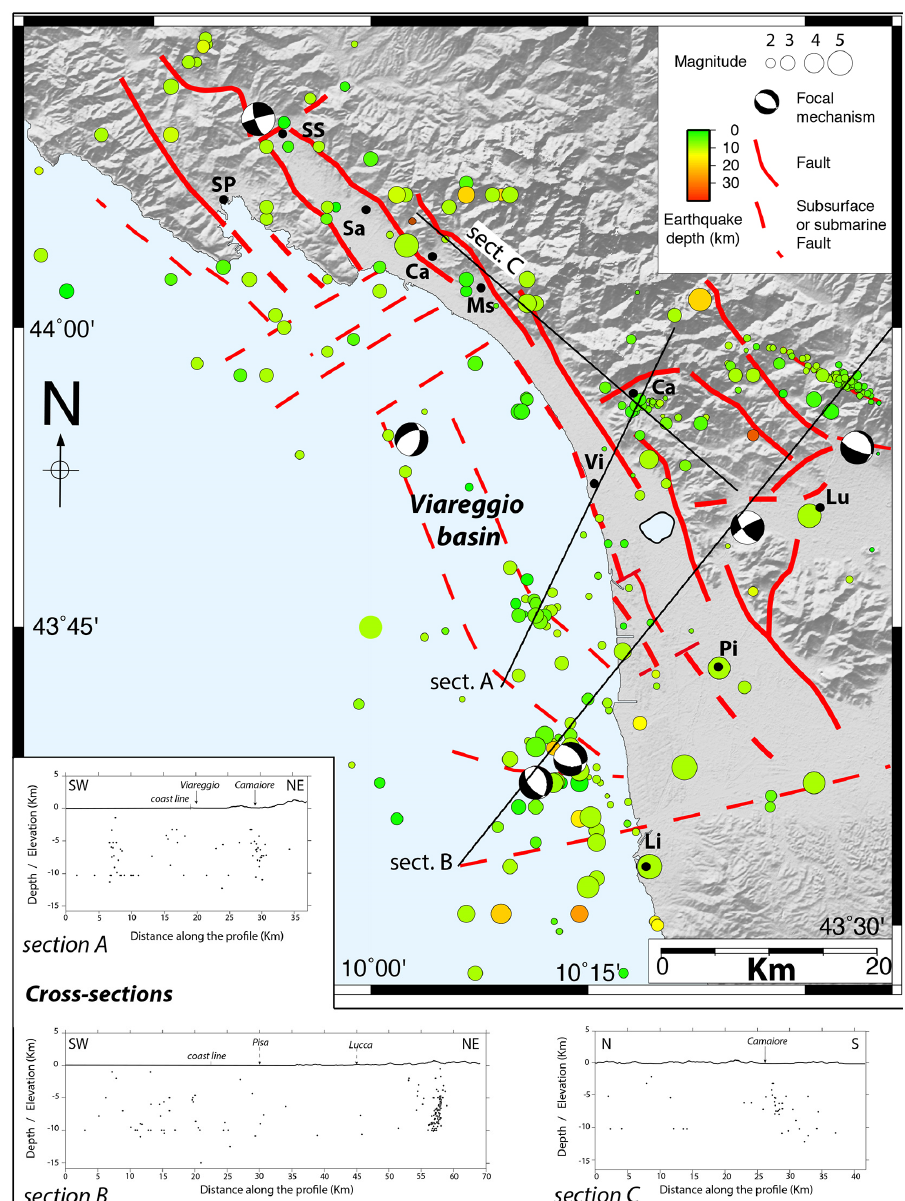
Figure 13. Faults and seismicity (1980–2013) in the Viareggio basin and surroundings. Focal mechanisms are from the INGV archive